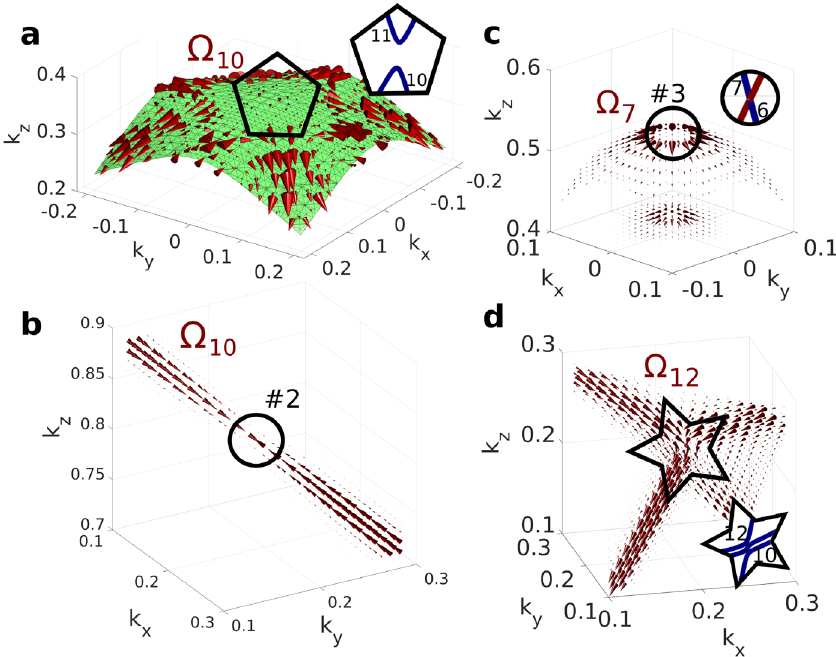
Figure 3. ( a ), Demonstration of the 2D flow of the Berry curvature of band 10 along a surface of maximal hybridization. ( b ), Berry curvature of band 10 exhibiting monopole drained via 1D flow. ( c ), Berry curvature of band 7 exhibiting monopole drained via 2D surface flow. ( d ), Berry curvature of band 12 demonstrating the transition of 2D flow into 1D flow. The respective band structure cutouts are shown in the insets. The size of the 2 2 2 2 largest cone is 500 bohr in ( a ), 1700 bohr in ( b ), 2000 bohr in ( c ), and 2600 bohr in ( d